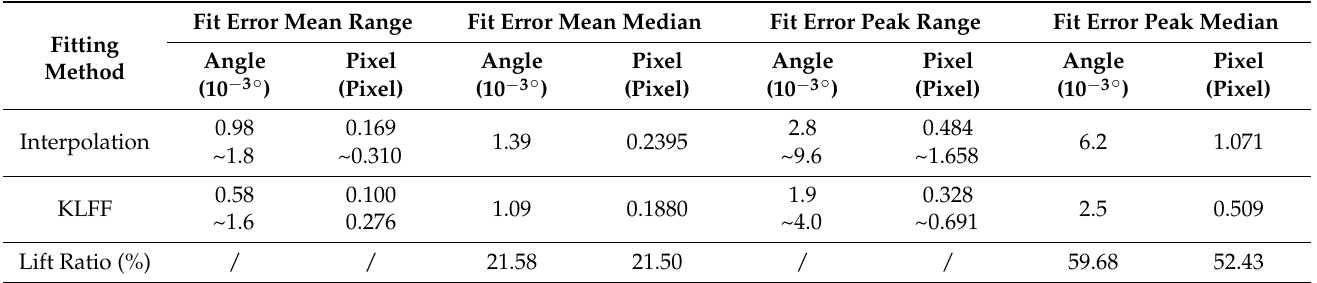
Table 3. Estimated error results of different algorithms after repeated